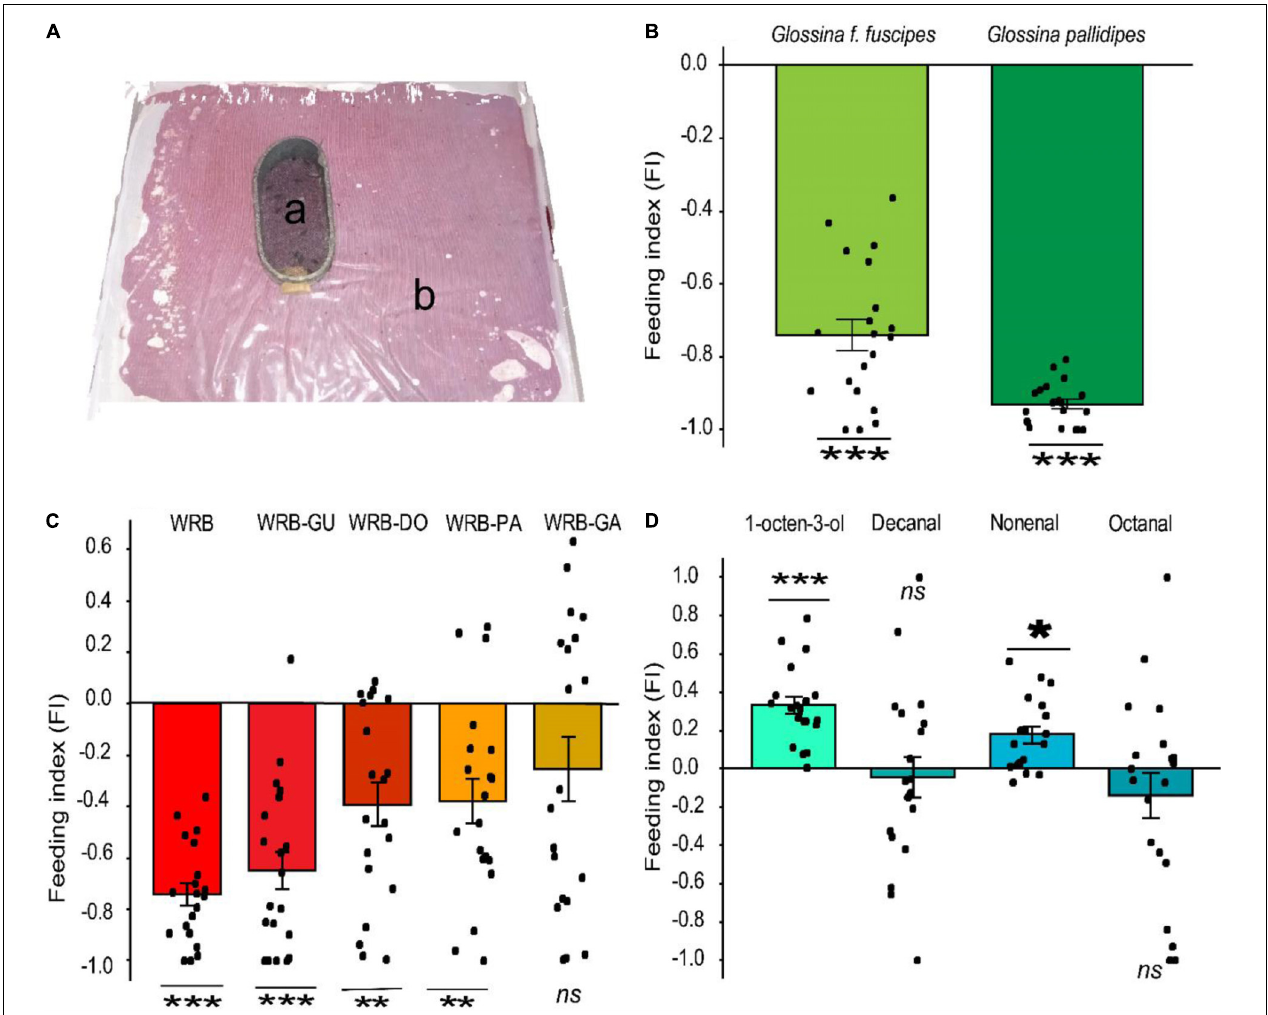
FIGURE 1 | Antifeeding effect of WRB. (A) Antifeeding bioassay setup: a represents the feeding cage, single fly/cage (original photo); b indicates the feeding tray containing sterile blood covered by a silicone membrane. (B) Feeding index (FI) of G . f . fuscipes and G . pallidipes fed on membrane treated with WRB. WRB, waterbuck repellent blend. Deviation of the feeding index from zero was tested with a Student’s t -test ( P < 0.05). (C) Feeding index (FI) of G . f . fuscipes fed on membrane treated with WRB and showing the contribution of each compound to the antifeeding effect. WRB-DO, WRB minus δ -octalactone; WRB-GA, WRB minus geranyl acetone; WRB-GU, WRB minus guaiacol; WRB-PA, WRB minus pentanoic acid. (D) Feeding index (FI) of G . f . fuscipes fed on membrane treated with positive controls (an attractant). Deviation of the feeding index from zero was tested with a Student’s t -test ( P < 0.05). Level of significance: *** P < 0.0001; ** P < 0.001; * P < 0.05, d represents the effect of size (Cohen’s d ) and ns means not significant. Error bars represent standard error, n = 20 for each test. The graphs and the statistics were generated using R software (R Core Team, 2018), (version 3.5.1),